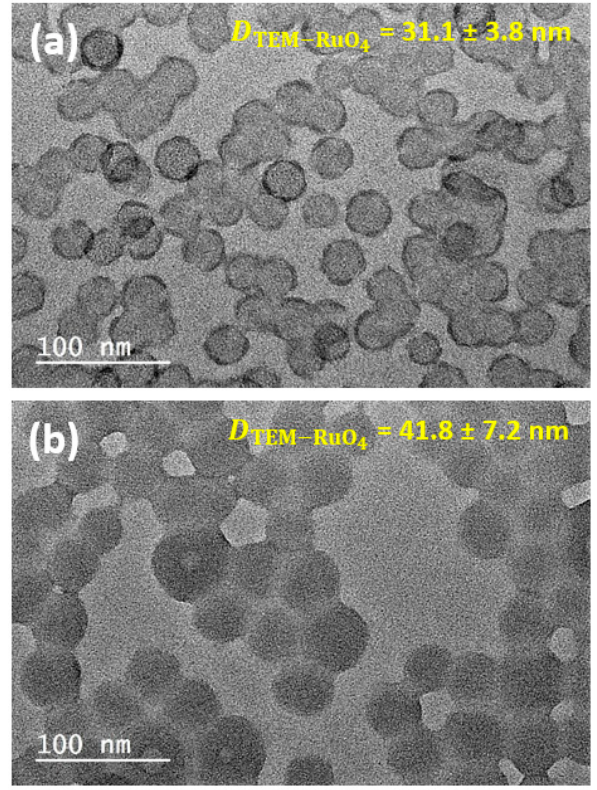
Figure 3. Positive staining electron microscopy (EM) images of ( a ) PHEA 85 – b –PS 130 and ( b ) PHEA 23 – b –PS